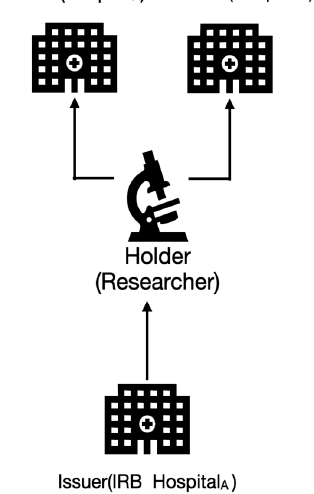
Figure 5. The DID-based trust model for cloud CDM.